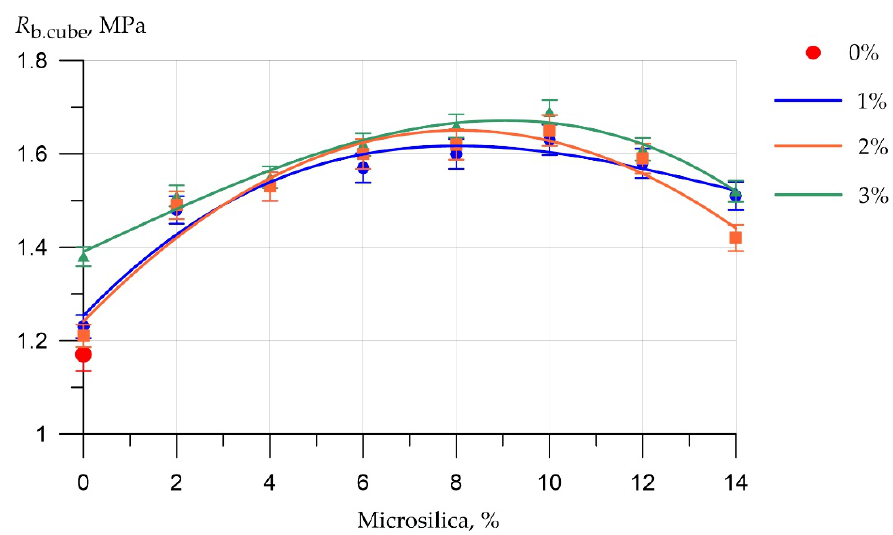
Figure 9. The results of determining the compressive strength of fiber foam concrete samples at various dosages of microsilica introduced instead of a part of the binder and dosages of polypropylene fiber of 0%, 1%, 2%, 3%.